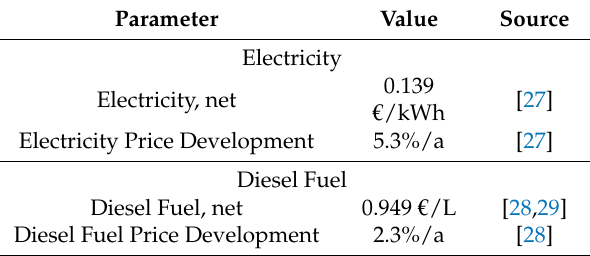
Table A2. Cost parameters for electricity and diesel